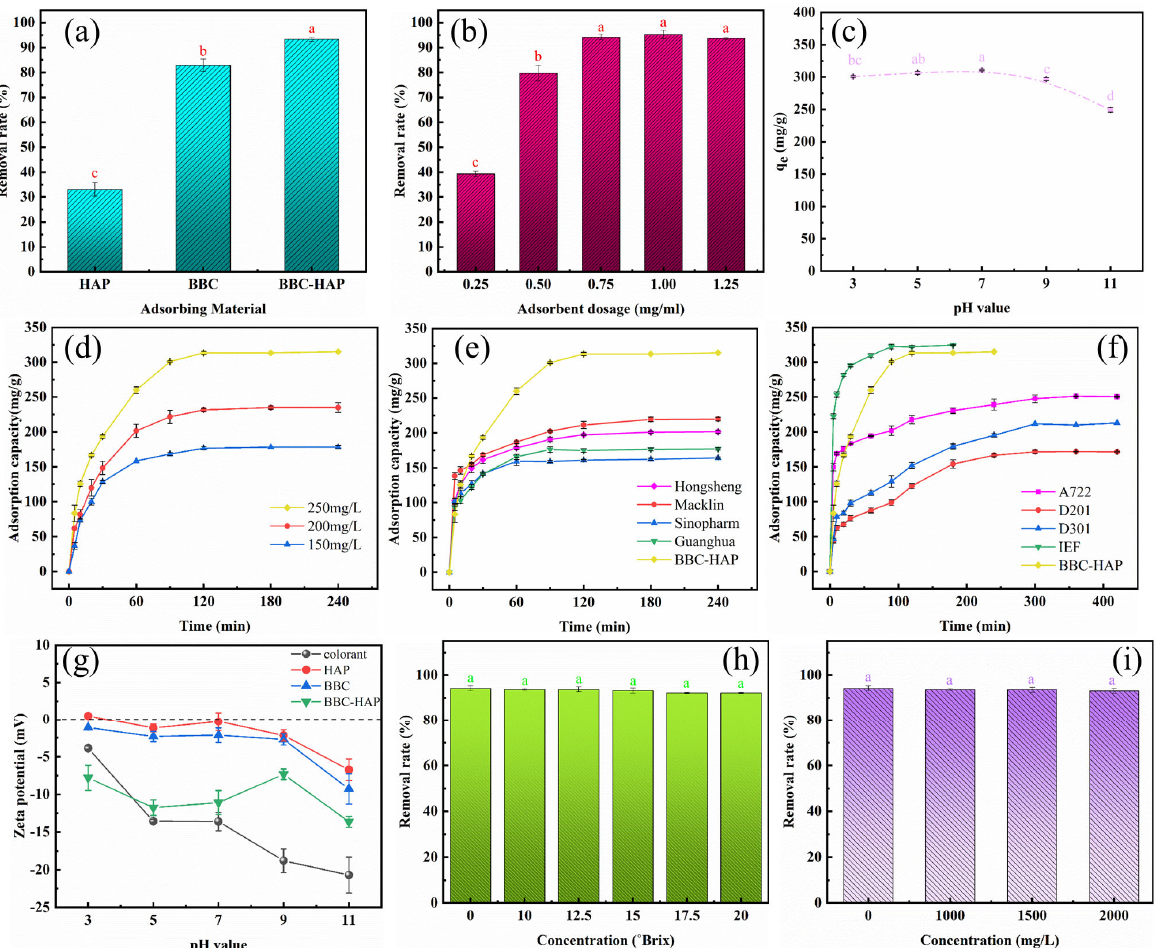
Figure 5. Adsorption experiments (General conditions: dosage, 0.75 mg/mL; temperature, 300 K; pH, 7; time, 6 h and initial colorant concentration, 250 mg/L). ( a ) Variations in colorant removal by different adsorbents. ( b ) Effect of BBC-HAP dosage on colorant removal. ( c ) Effect of pH on the equilibrium adsorption capacity of BBC-HAP for colorant. ( d ) Effects of initial colorant concentration and contact time on the adsorption capacity of BBC-HAP. ( e ) Colorant adsorption by four activated carbons. ( f ) Colorant adsorption by three commercial resins and one ion exchange fiber. ( g ) Zeta potential of colorant, HAP, BBC, and BBC-HAP. ( h ) Effect of sucrose solution concentration on the adsorption capacity of BBC-HAP for colorant (time, 2 h). ( i ) Effect of KCl concentration on the adsorption capacity of BBC-HAP for colorant (time, 2 h). Data represent mean values ± SD ( n =